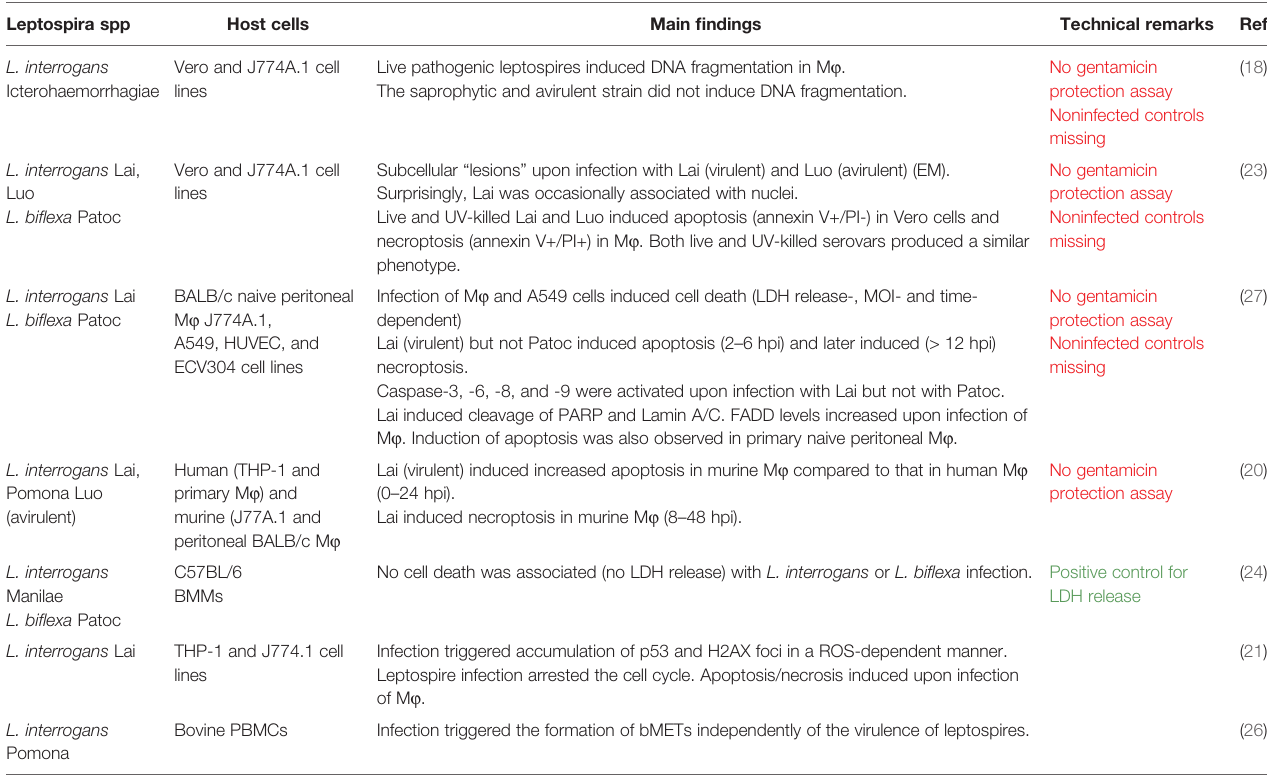
TABLE 3 | Leptospira- induced apoptosis and cell